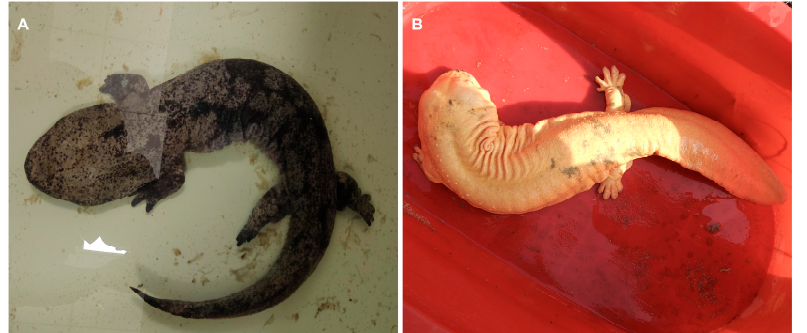
Figure 1. Two skin color types of Andrias davidianus . ( A ). Wild-type (WT) Andrias davidianus . ( B ). Albino (AL)-type Andrias davidianus . Table 1. Overall statistics based on the reads of the mRNA sequencing data.